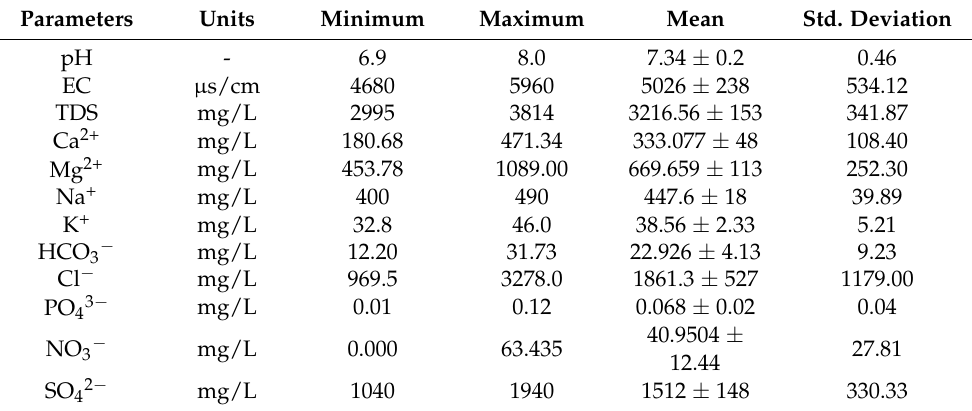
Table 4. Statistical summary of the physicochemical parameters of groundwater samples.